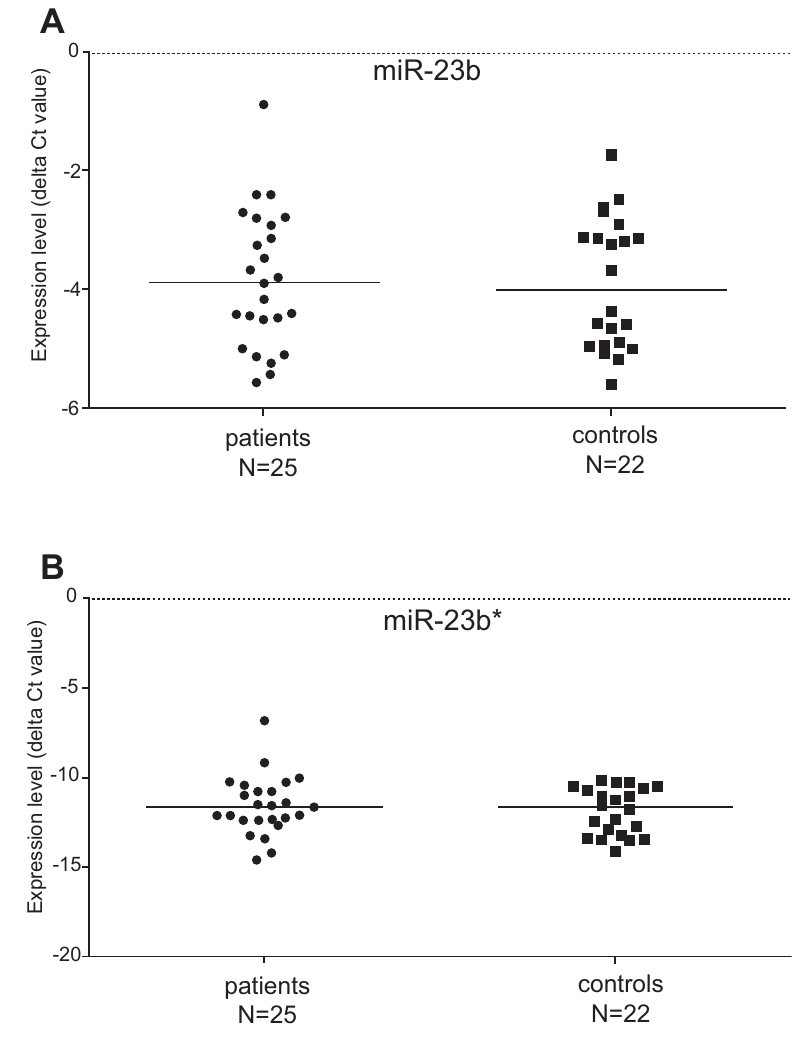
Figure 1. Regulation of the miR-23b and miR-23b* expression in patients and controls. The expression level of miR-23b was not significantly changed in patients suffering from idiopathic inflammatory myopathy when compared with healthy controls ( A ). No significant difference in expression of miR-23b* was found between myositis patients and controls ( B